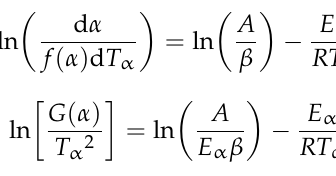
Based on the Arrhenius equation, the Achar differential and Coats–Redfern integral model are described as follows